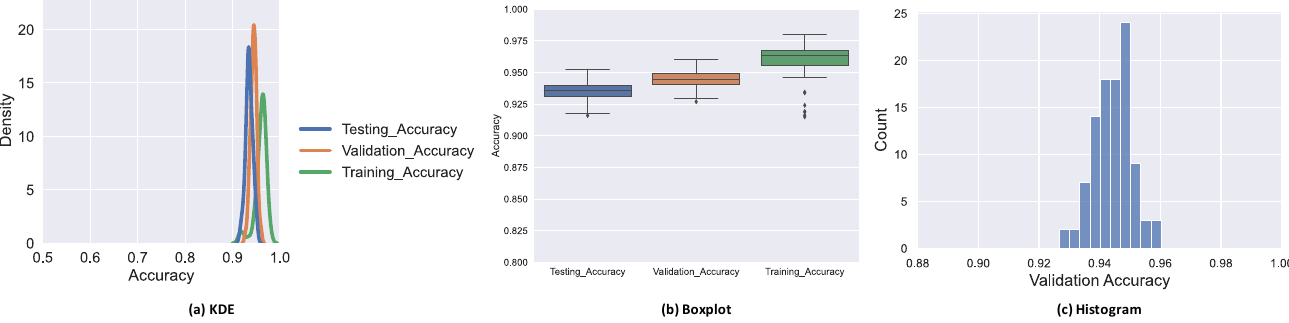
Figure 8. Kernel density estimation ( a ); box plot ( b ) for training, validation, and testing accuracy; validation accuracy histogram ( c